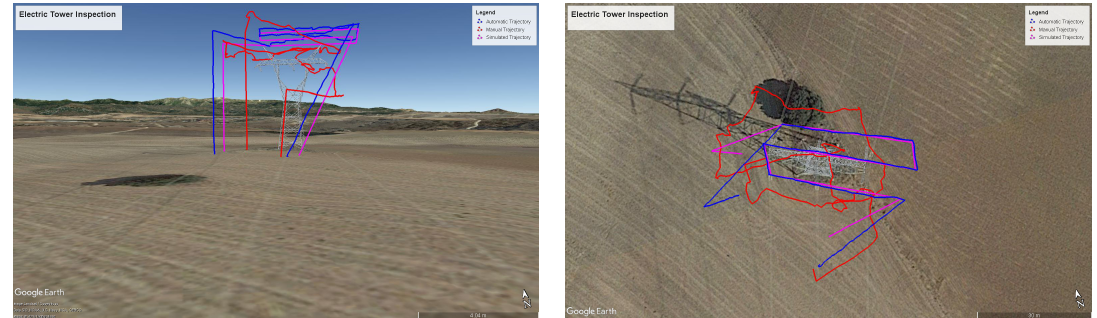
Figure 10. Manual (red), automated (blue) and MDS simulated/predicted (magenta) 3D trajectory: ( left ) lateral, ( right )